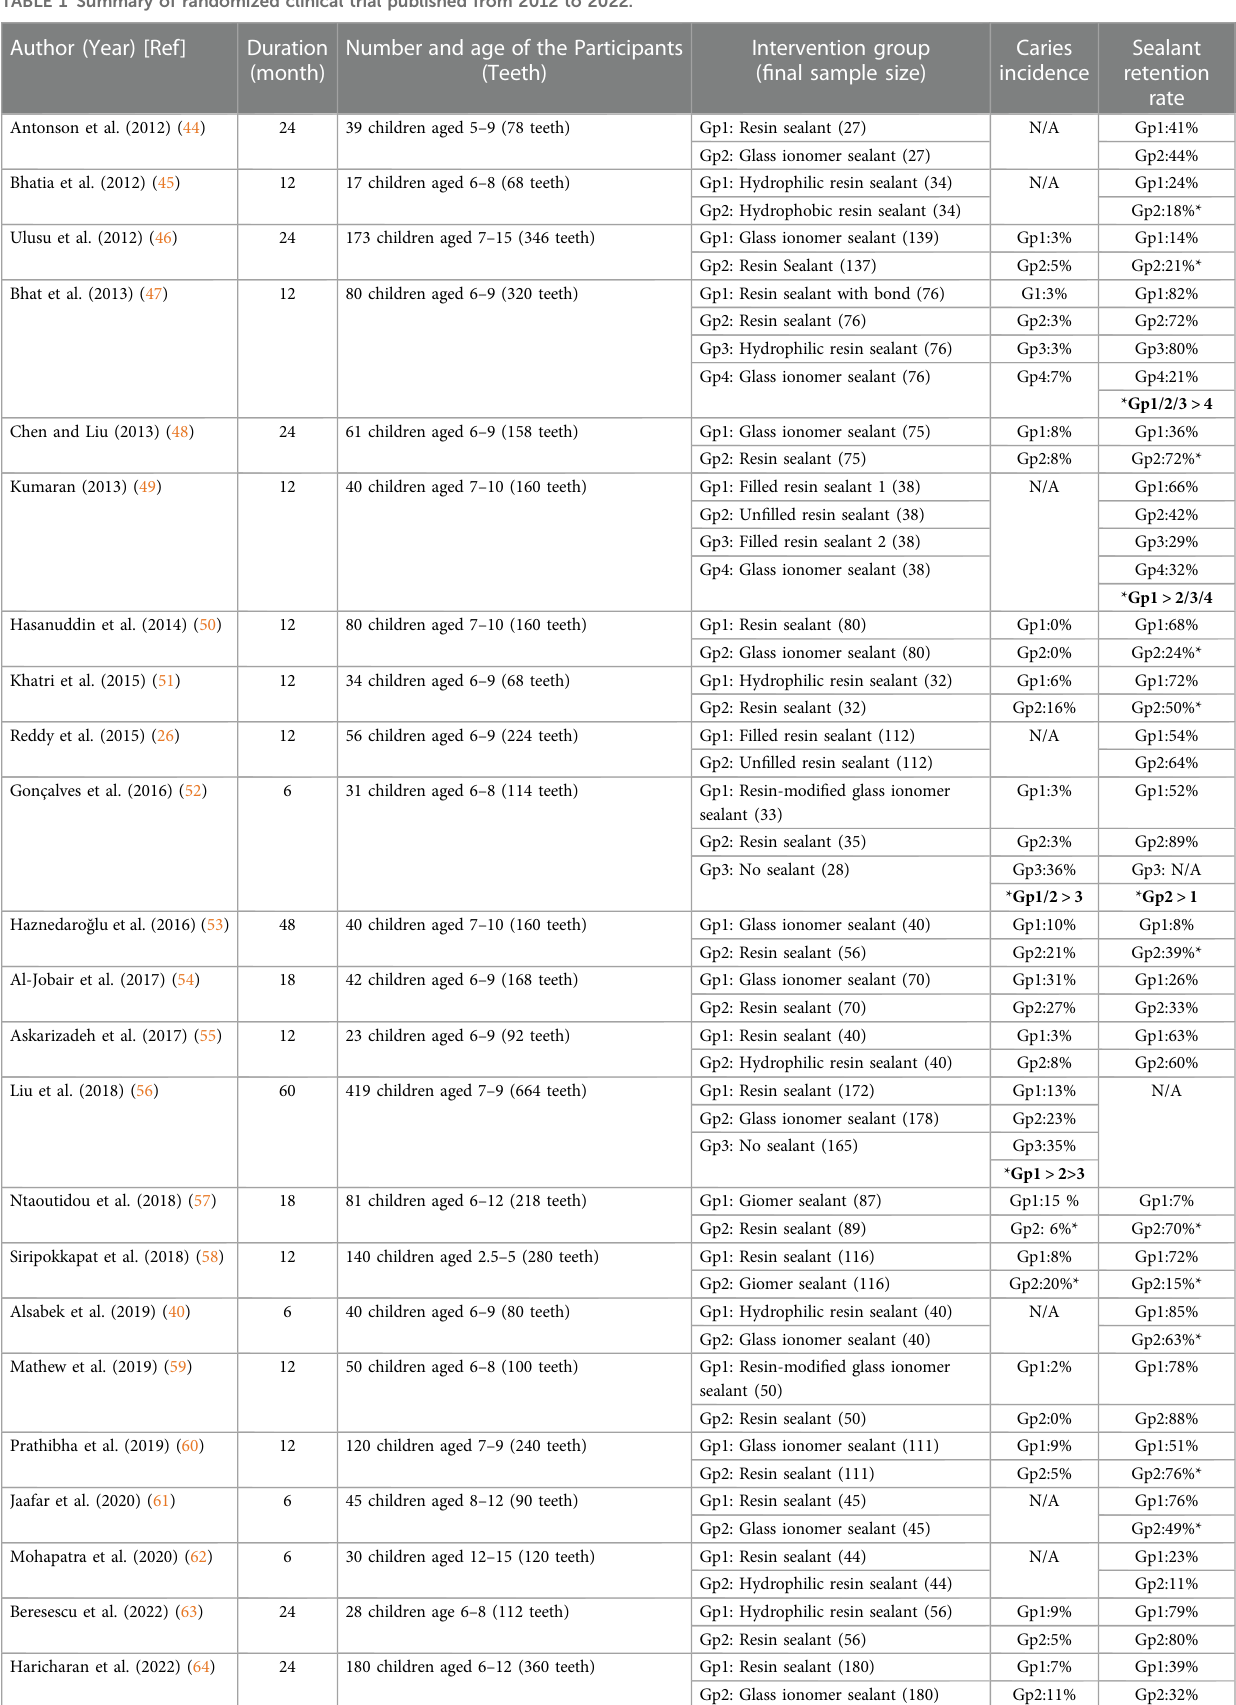
TABLE 1 Summary of randomized clinical trial published from 2012 to